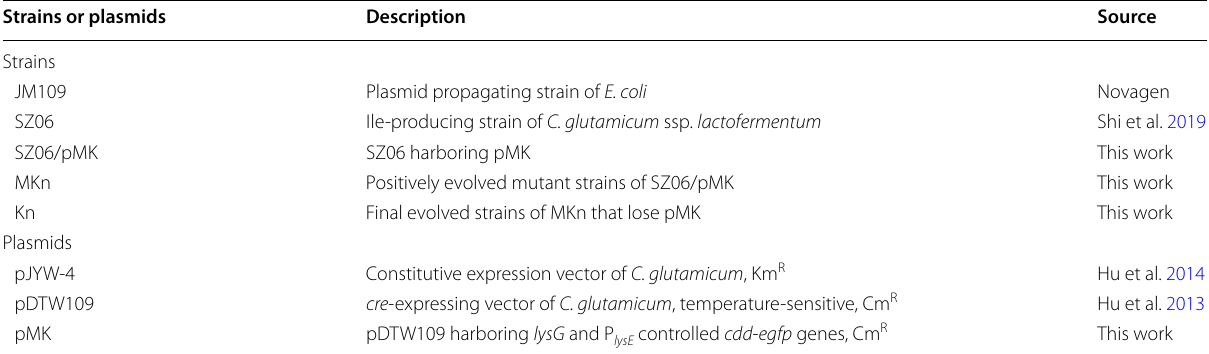
Table 1 Bacterial strains and plasmids used in this study Strains or